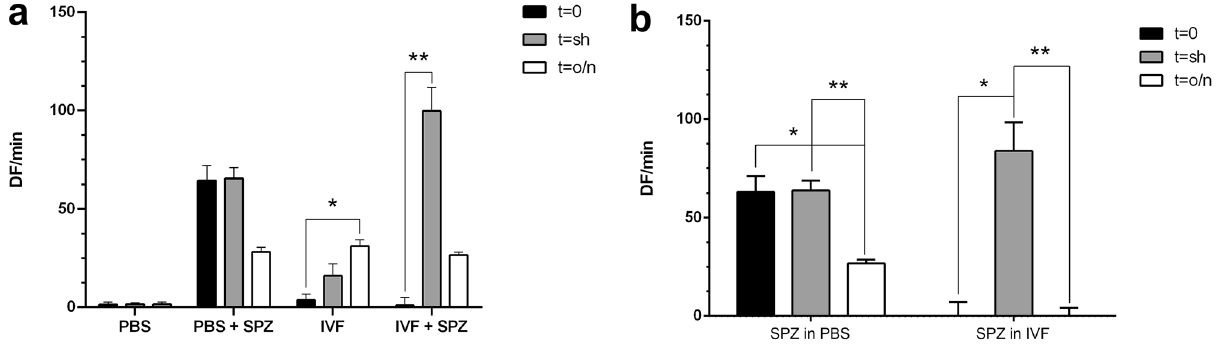
Figure 5. Spermatozoa ROS production. Reactive oxygen species (ROS) generation measured as 2 ′ ,7 ′ -dichlorodihydrofluorescein diacetate (H 2 DCFDA) oxidation rate, calculated as mean and standard deviation of fluorescence intensity slope as a function of time (DF/min) in the linear region (corresponding to the first 10 min of the kinetic measurement. ( a ) ROS level detected in PBS and IVF medium with and without spermatozoa in time points t = 0, t = sh (shIVF), t = o/n (o/nIVF). ( b ) ROS level produced by spermatozoa in PBS and IVF medium in time points t = 0, t = sh (shIVF), t = o/n (o/nIVF). * means P <